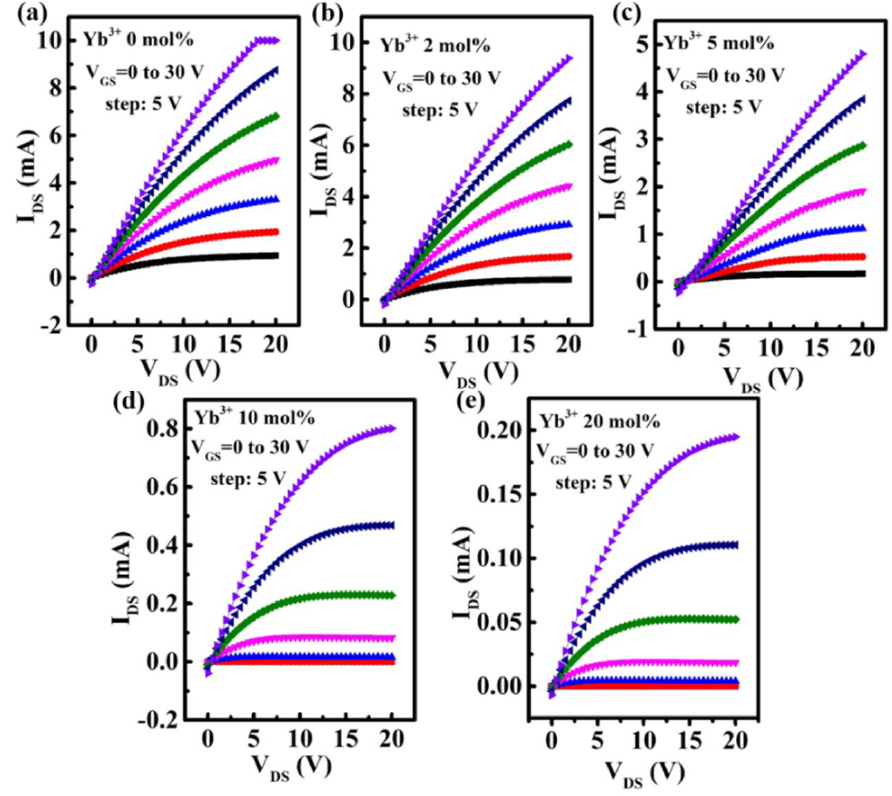
Figure 8. Output characteristics of In-Yb-O TFTs with Yb doping ratios of: ( a ) 0%, ( b ) 2%, ( c ) 5%, ( d ) 10%, and ( e ) 20%.